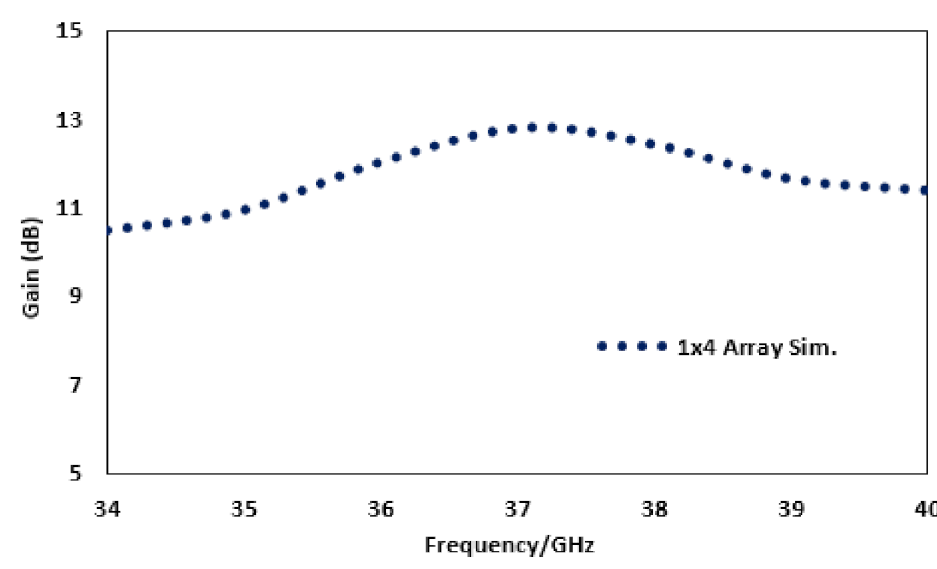
Figure 4. Gain of the four element antenna